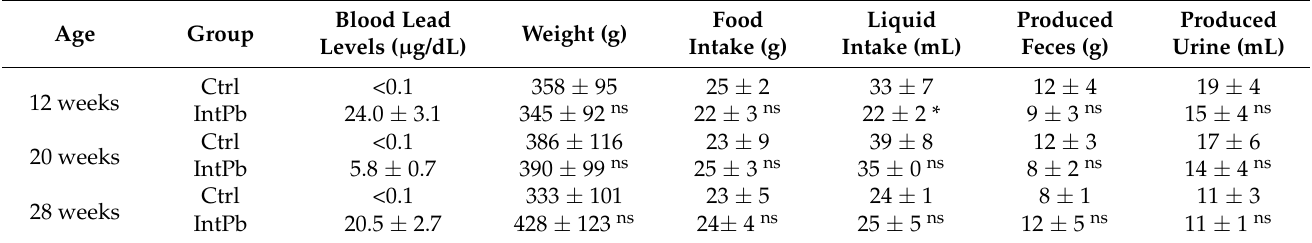
Table 1. Blood lead levels and metabolic parameters of animals exposed to lead compared to controls. Values are the mean ± SD. The asterisks denote statistically significant differences between groups; ns —not significant, * p < 0.05; two-way ANOVA, with multiple comparisons (Tukey’s test); n = 6/group.